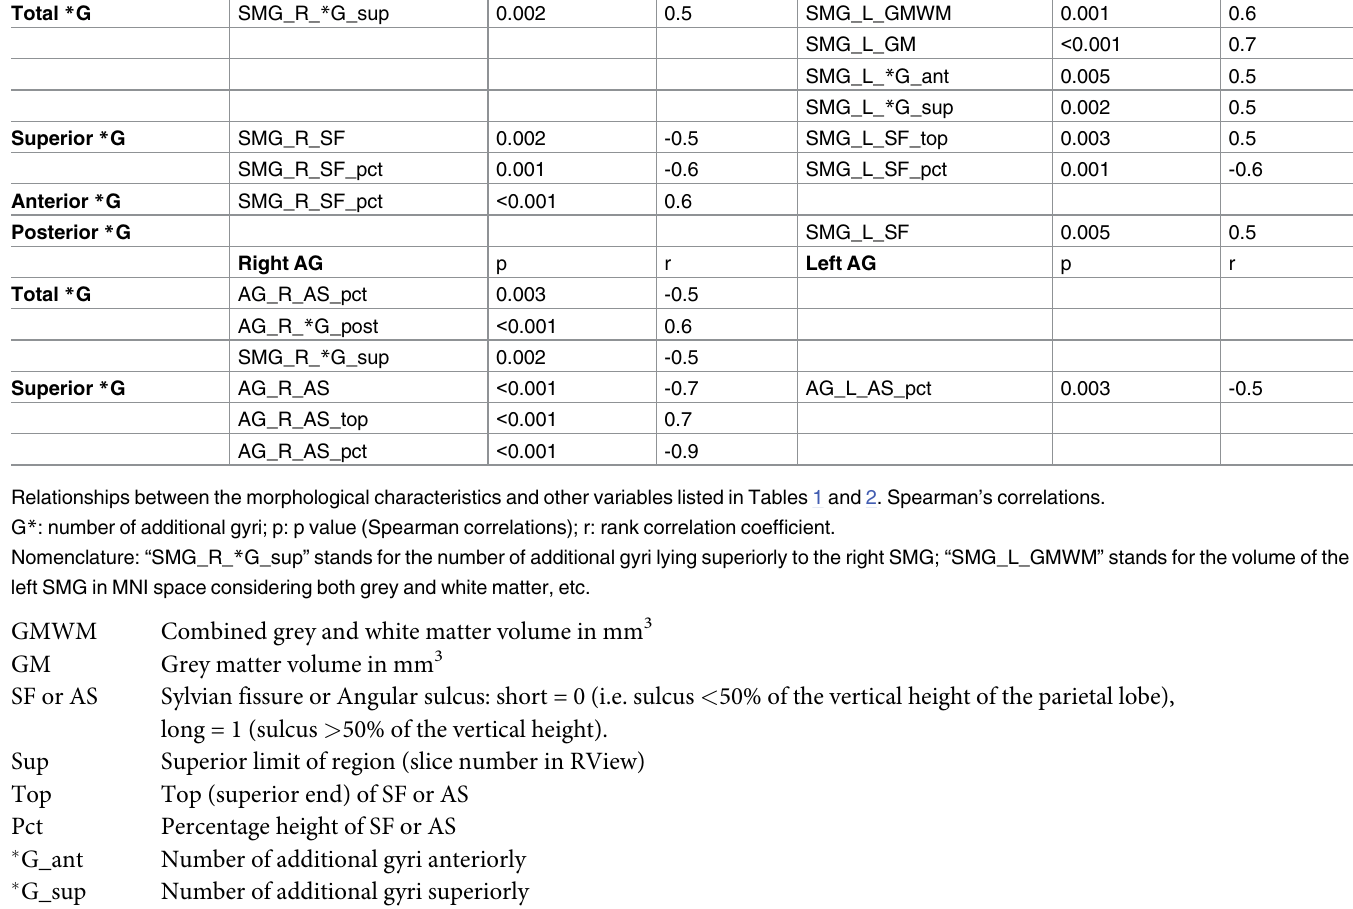
Table 5. Intraregional / intrahemispheric additional gyri (G * ). Right SMG p r Left SMG p